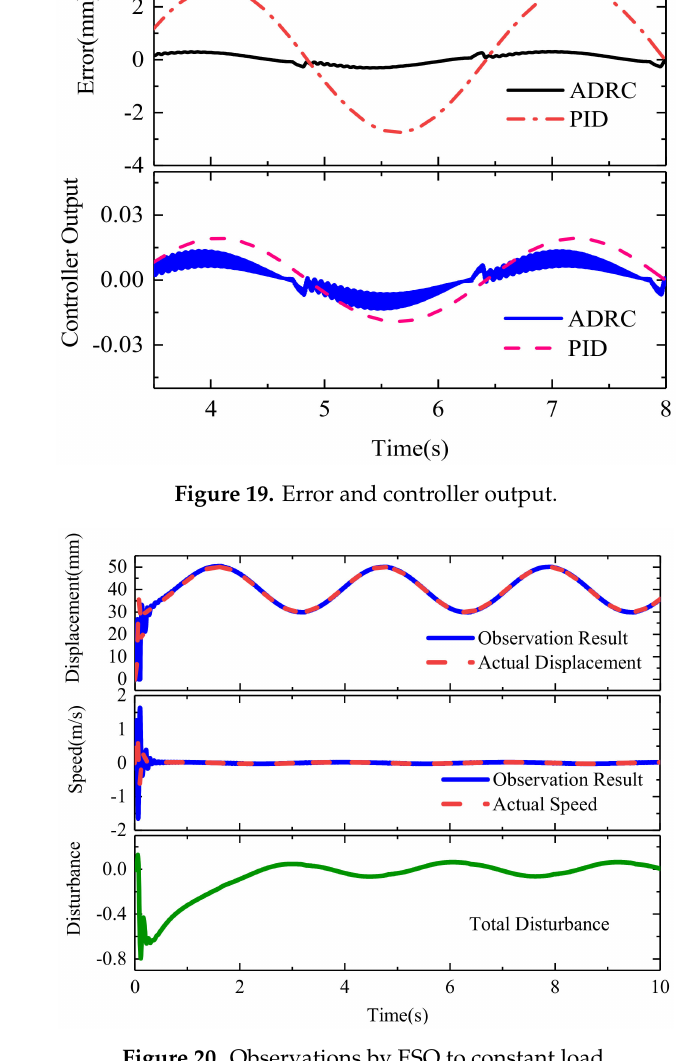
Figure 20. Observations by ESO to constant